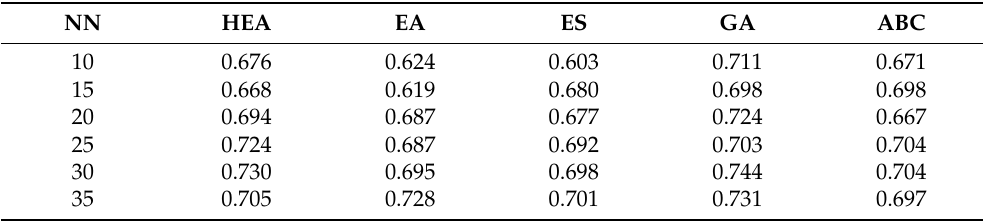
Table 11. Tabulated GLI values for different DHNN-RAN k SAT models. The notation * means no value has been generated in that particular